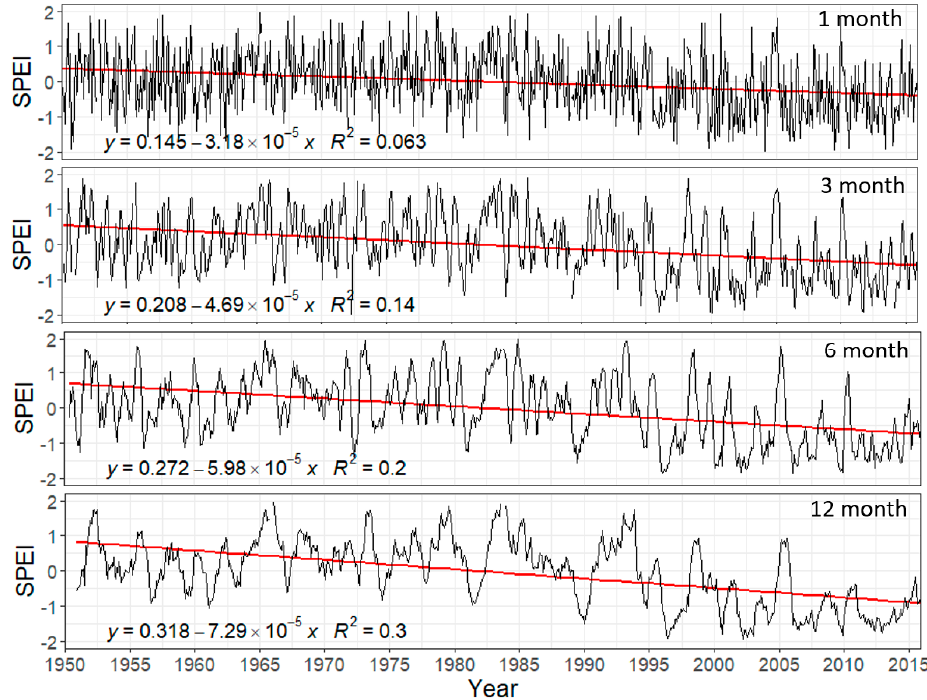
Figure A1. The conceptual figure of different SPEI timescales used in the study for April ( a ) and September ( b ).